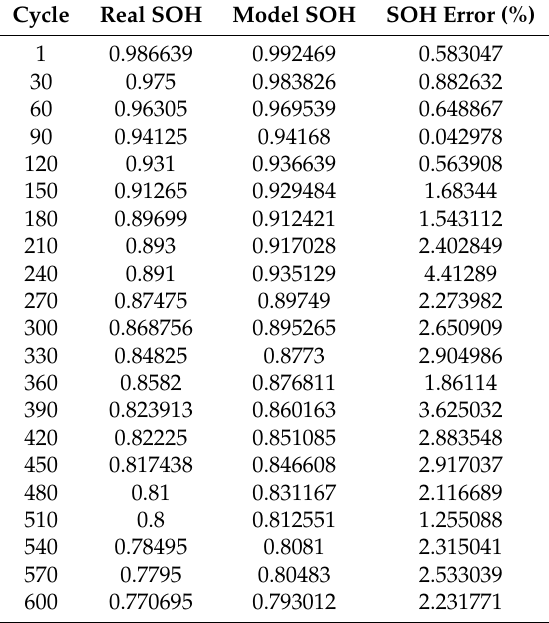
Table 6. Numerical results for the comparison between the linear regression model based on the IC curve peak point of cell no. 1 and a real SOH for the IC curve peak point of the retired cell (SOH error = Real SOH − Model